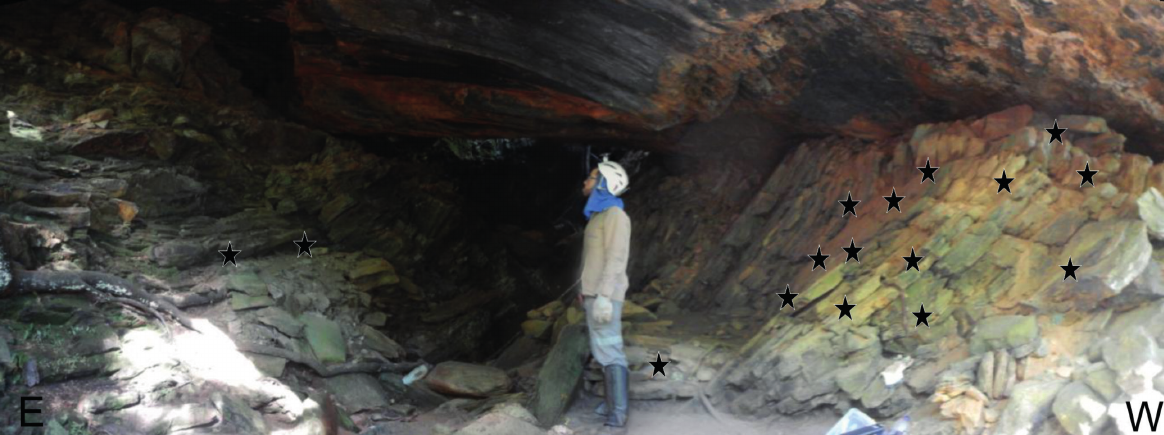
Figure 4 - the black stars indicate the tooth traces in the cave CMN-0022, which are mostly concentrated on the western wall at the northern entrance.